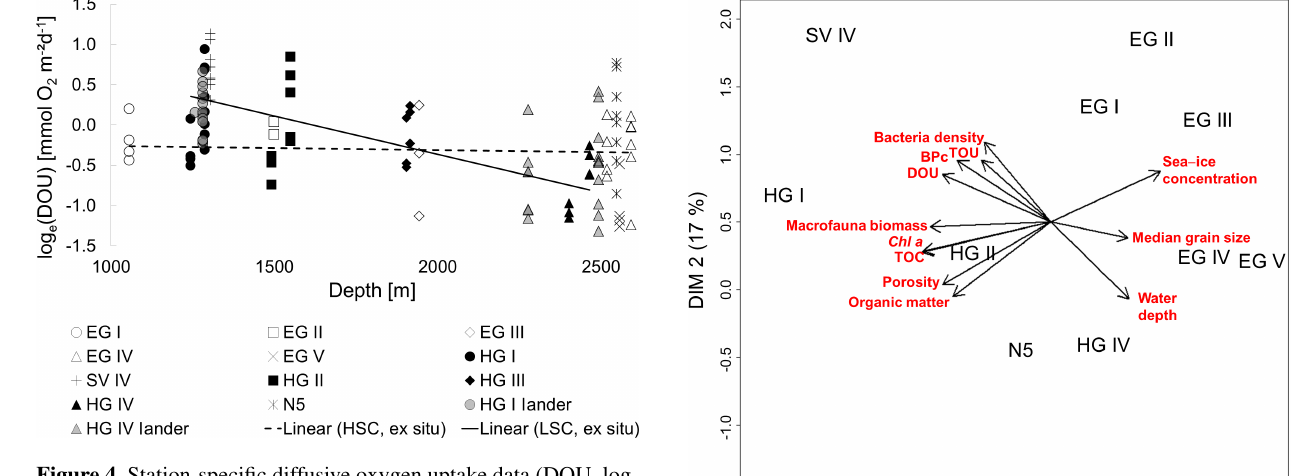
Figure 4. Station-specific diffusive oxygen uptake data (DOU, log- transformed) at investigated stations and as a linear function of wa- ter depth (from ex situ values) in the area of high sea-ice concentra- tion (HSC) and low sea-ice concentration (LSC) in the Fram Strait. The full line indicates a significant decrease in DOU with water depth in the LSC area, while the dashed line indicates that the slope did not differ significantly from zero in the HSC area.